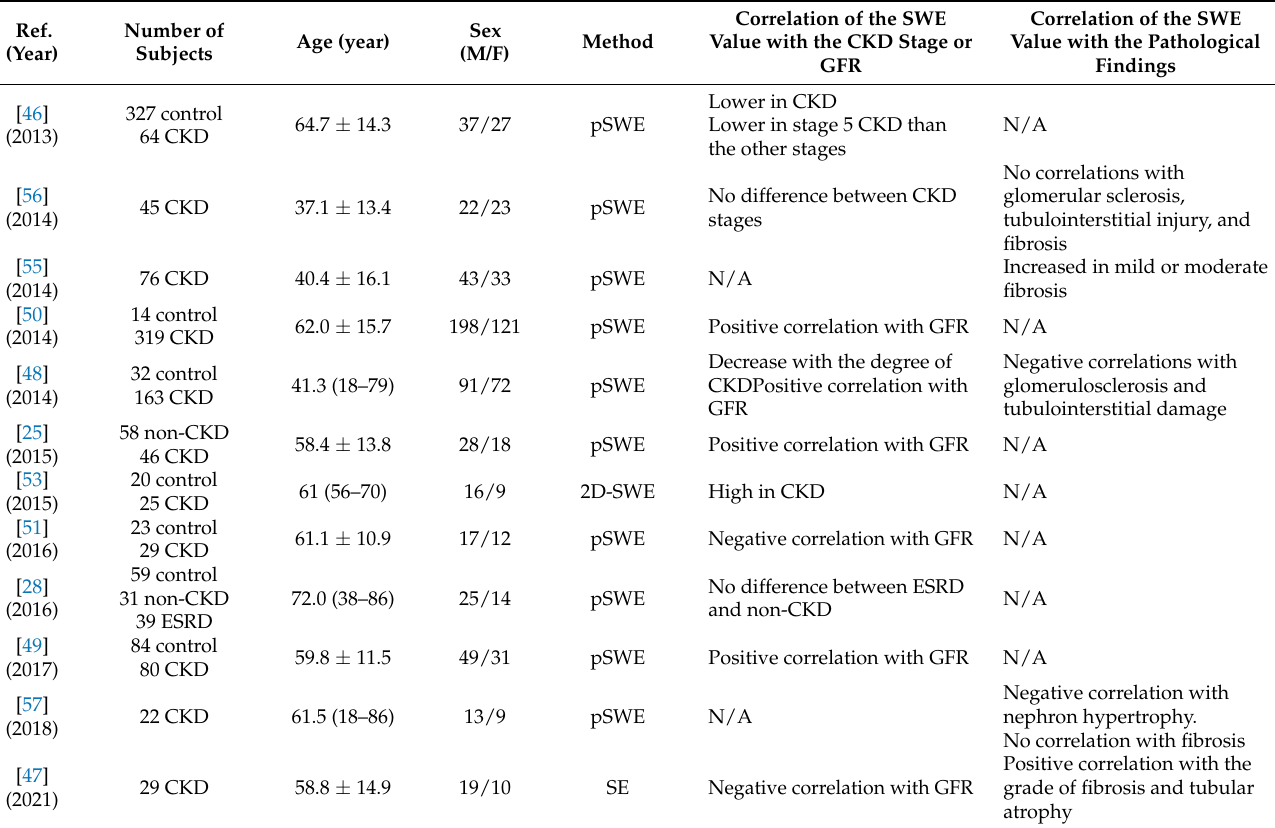
Table 2. Summary of the previous findings of shear wave elastography in patients with chronic kidney disease. Ref.